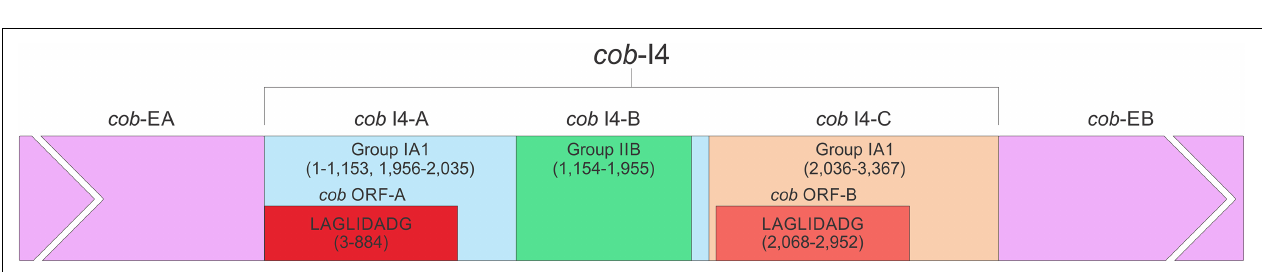
FIGURE 9 | cob- 490 intron schematic diagram. cob i4, the entire complex intron at cob 490 position. cob i4-A, cob i4’s upstream group IA intron; cob -EA, upstream exon; cob ORF-A, cob i4-A’s ORF; cob i4-B, cob i4’s middle group IIB intron; cob i4-C, cob i4’s downstream group IA intron; cob ORF B, cob i4-C’s ORF; cob -EB, downstream exon. LAGLIDADG represents type of homing endonuclease ORF encoded by group I intron. The numbers in brackets represent the position and length of each intron element relative to the start of cob i4. As the two group I introns are of the same subtype, their interactions can be interchangeable; components of the internal members can interact with components of the external member to form paired